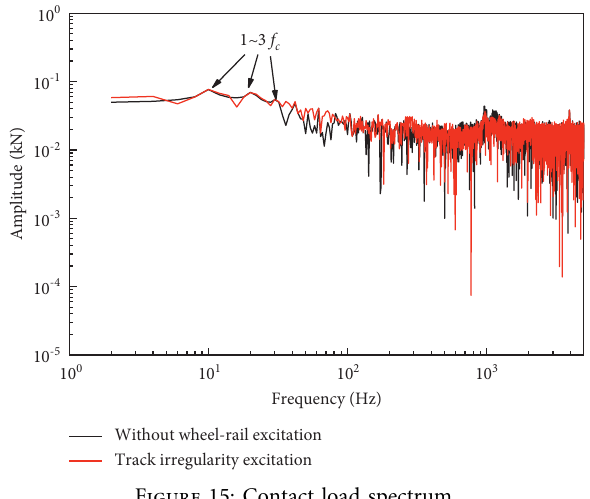
Figure 15: Contact load spectrum.